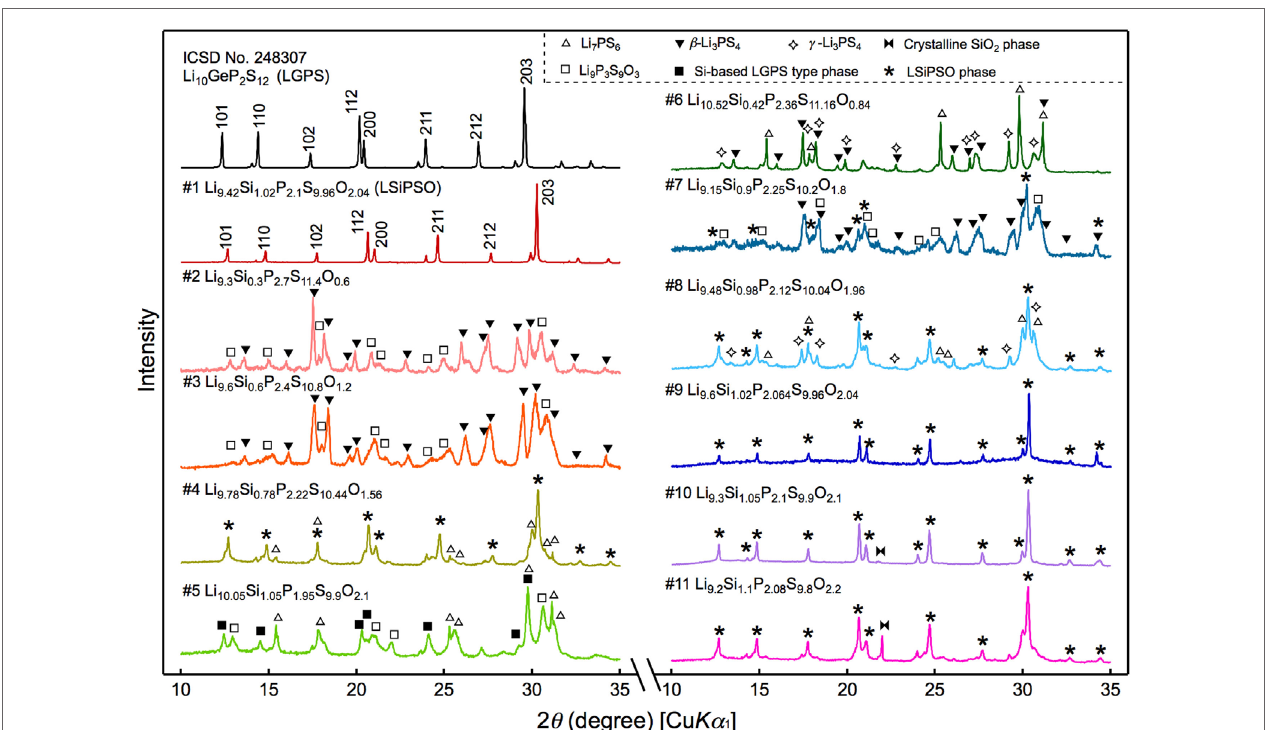
FigUre 2 | X-ray diffraction patterns for the synthesized samples and that of the original lgPs phase . The sample numbers and compositions correspond to those shown in Figure 1